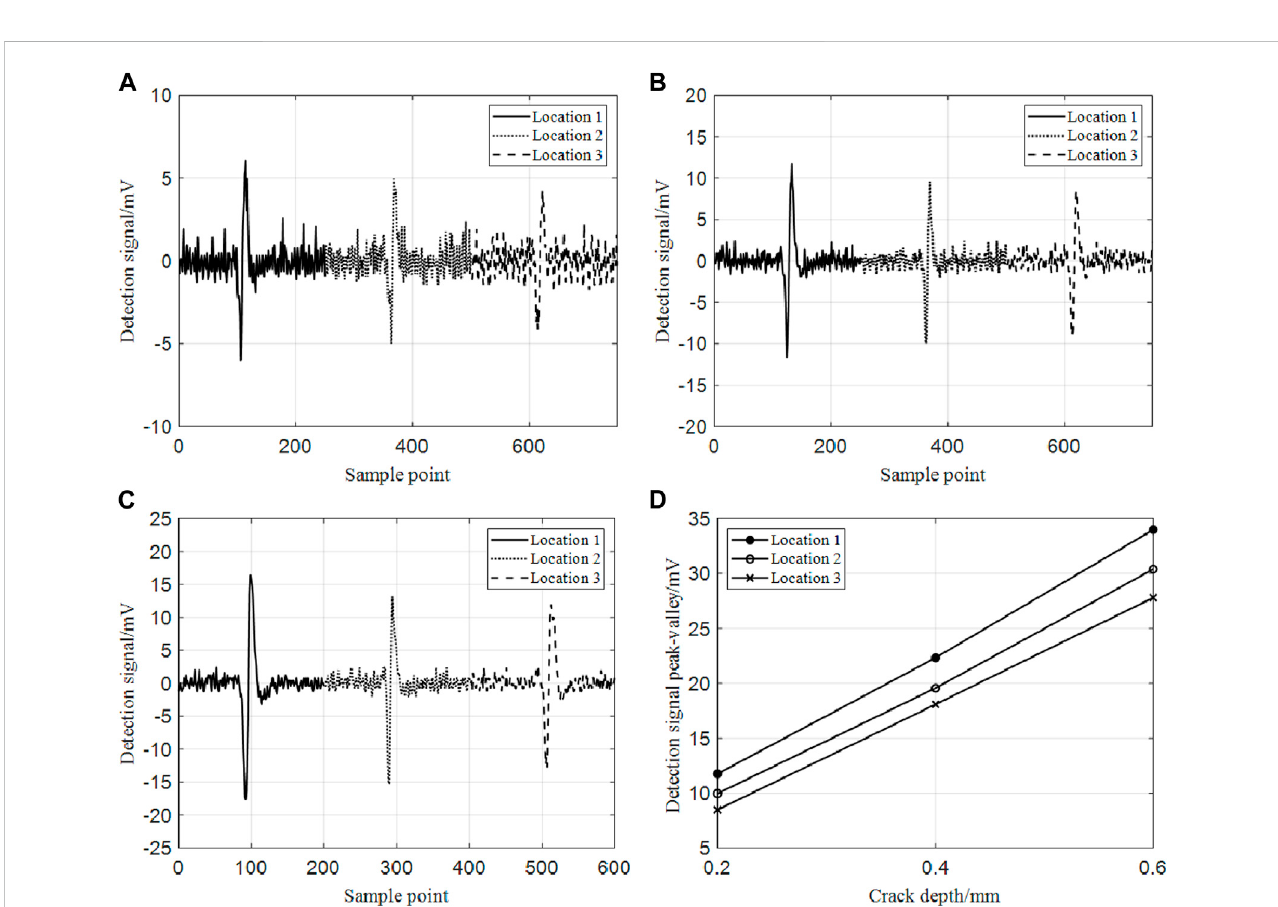
FIGURE 13 (A) Experimentalsignalsondifferentradiusofcurvaturewithacrackdepthof2 mm; (B) Experimentalsignalsondifferentradiusofcurvaturewithacrack depth of .4 mm (C) Experimental signals on different radius of curvature with a crack depth of .6 mm (D) Peak and valley values of the experimental signal of different models bearing rings at different